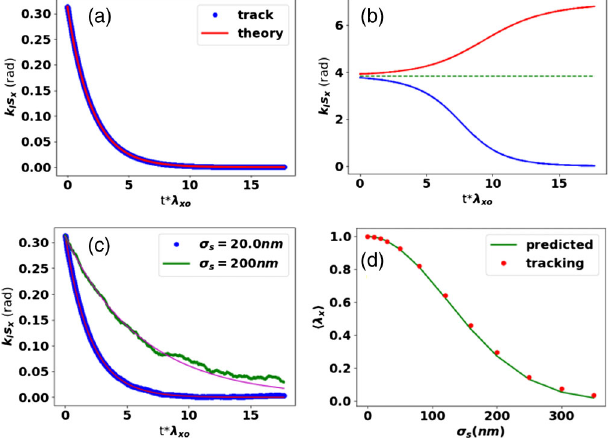
FIG. 3. Results from the fast tracking routine: part (a) demon- strates agreement between theoretical damping rate and tracking for a small amplitude particle while (b) verifies a reduction in the damping rate at large amplitude and a cooling boundary at J ð μ Þ . Part (c) shows examples of the reduction in the damping 1 1 ; 1 rate when a path-length jitter is applied as well as exponential best fits used to extract the reduced rates. Finally, (d) plots the reduced damping rate for a given rms path-length jitter from tracking with the prediction from Eq.